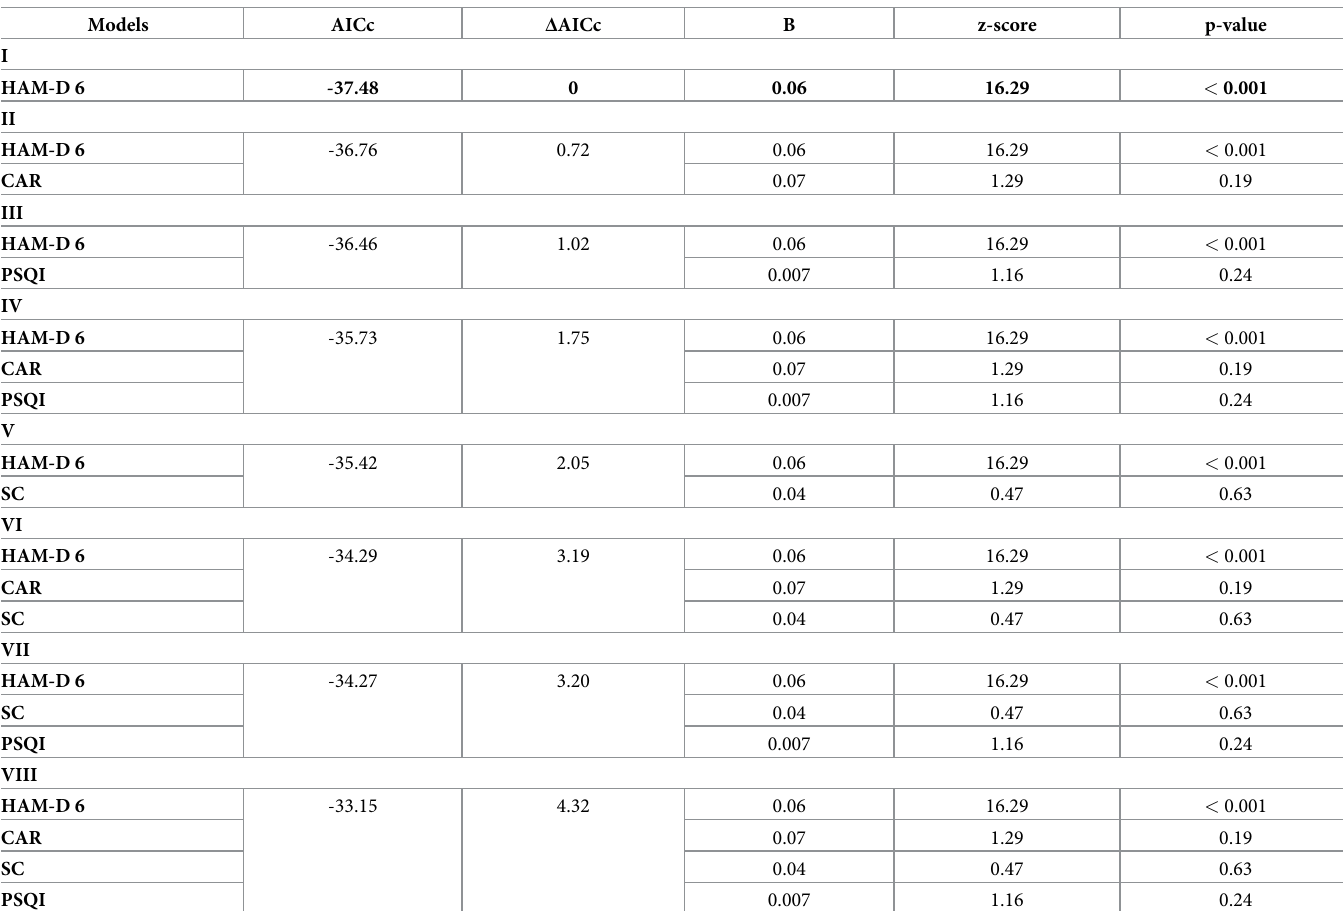
Bold result indicates the best regression model with the lowest AICc and Δ AICc < 2. All models showed in this table were statistically significant (p < 0.05) and controlled by age and sex, while four of them had Δ AICc < 2. CAR: cortisol awakening response; SC: serum cortisol; PSQI: Pittsburgh sleep quality index; HAM-D 6: Hamilton Depression Rating Scale with 6